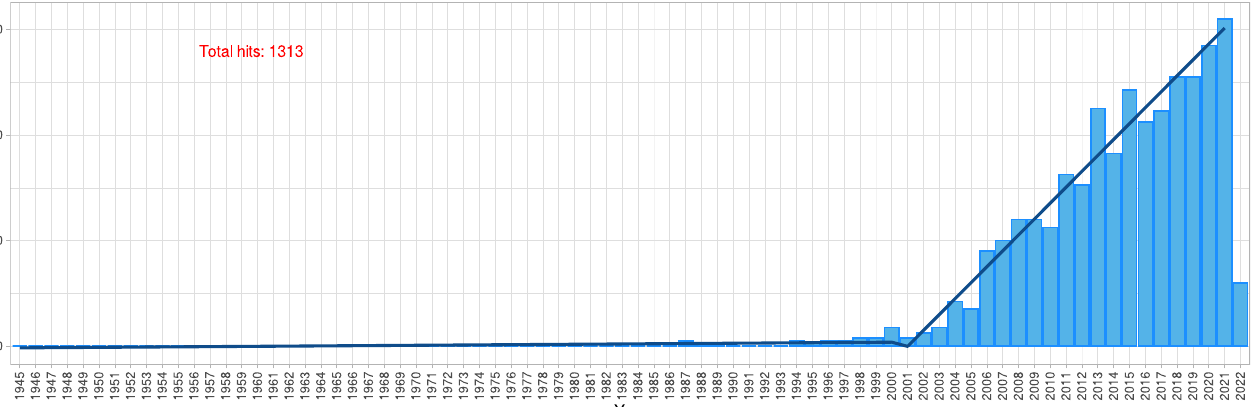
Figure 1. Bar chart of the number of biomedical publications per year obtained by a computational search of the PubMed database for “(naive Bayesian OR naive Bayesian classifier OR probabilistic classifiers) NOT review [Publication Type]”. The line shows the bilinear trend in the number of publi- cations with an acceleration from year 2001. The figure has been created using the software package R (version 4.1.3 for Linux; https://CRAN.R-project.org/ (accessed on 18 September 2022) [12] accessed on 18 September 2022 and the R library “ggplot2” (https://CRAN.R-project.org/package=ggplot2 (accessed on 18 September 2022)